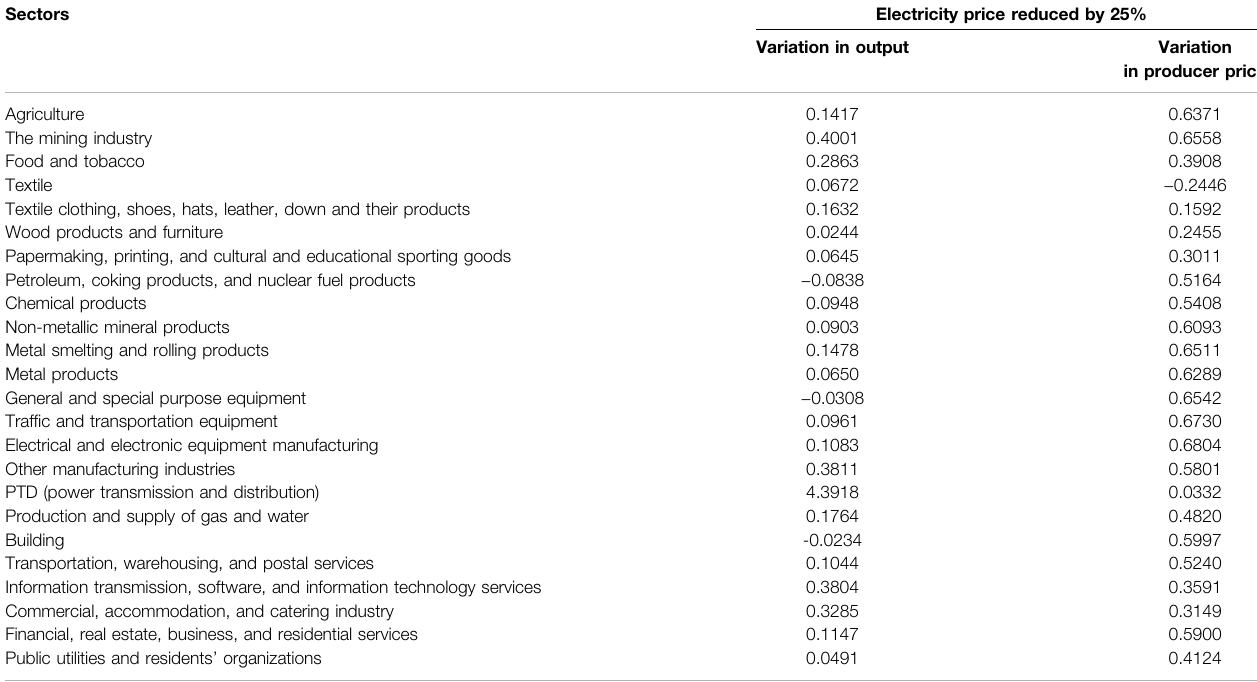
TABLE 3 | Impact of general industrial and commercial electricity price reduction on the output and producer price of sectors (%).